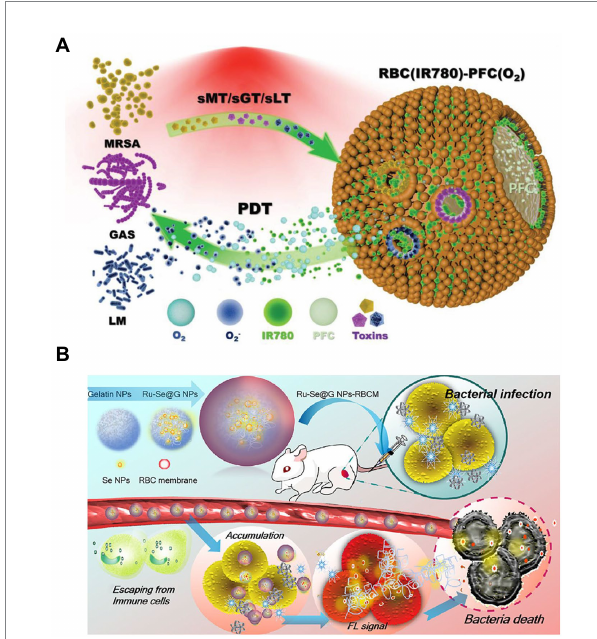
FIGURE 2 Schematic diagrams of microenvironment-responsive RBC membrane-coated nanosystems. (A) “On-demand” photodynamic therapy (PDT) of bacterial infection. The constructed RBC(IR780)- PFC(O 2 ) nanobubbles can bind to and neutralize toxins secreted by MRSA, GAS, and LM (named sMT, sGT, and sLT, respectively). After absorbing toxins, the formed pore stimulated the release of the photosensitizer IR780 and oxygen. Subsequently, the released agent contributed to the enhancement of PDT efficiency in killing bacteria under NIR irradiation. Reprinted with permission from Zhuge et al. (2022) (Copyright© 2022, Wiley-VCH). (B) The prepared Ru − Se@ GNP-RBCMs can escape from immune cells, accumulate at infectious sites, and realize responsive release of Ru − Se nanoparticles. The synergistic antibacterial effect finally resulted in